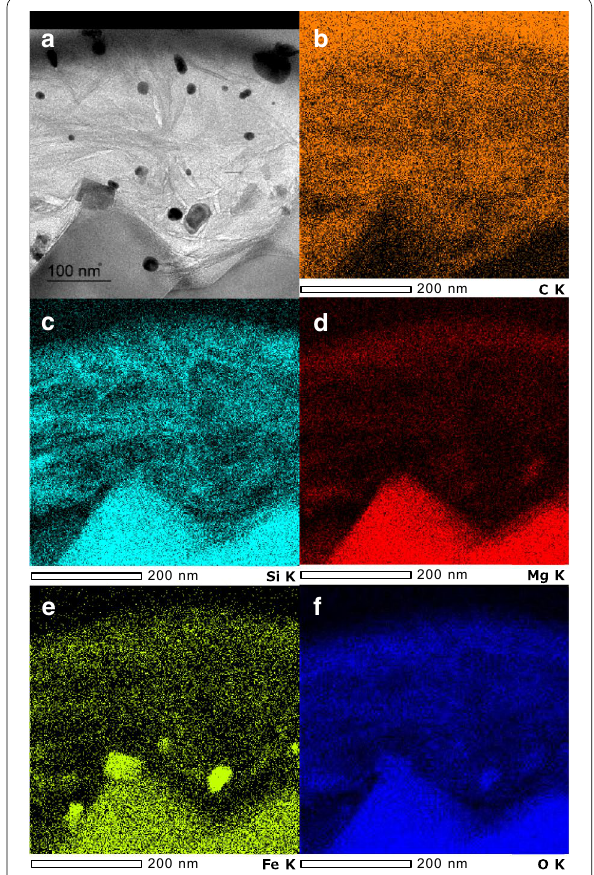
Fig. 3 a A TEM image of the boundary area between etch pits